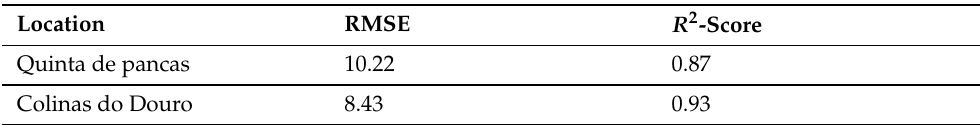
Table 7. Performance of the trained BiLSTM model to predict the FTSW one day ahead on the Quinta de Pancas test